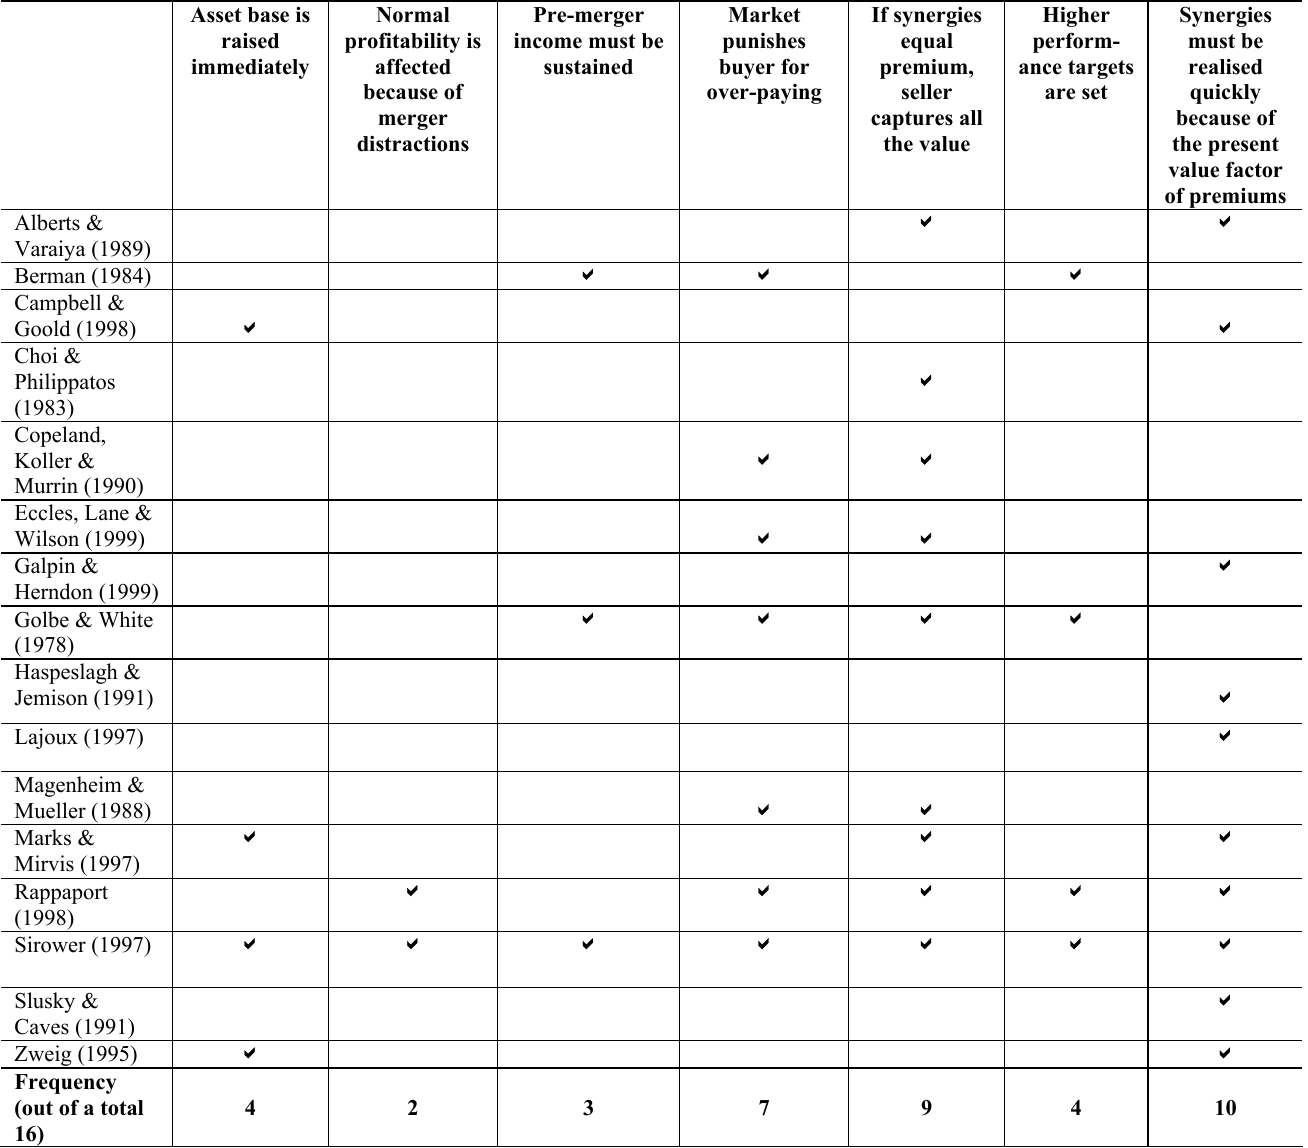
Table 2: Consequences of paying an acquisition